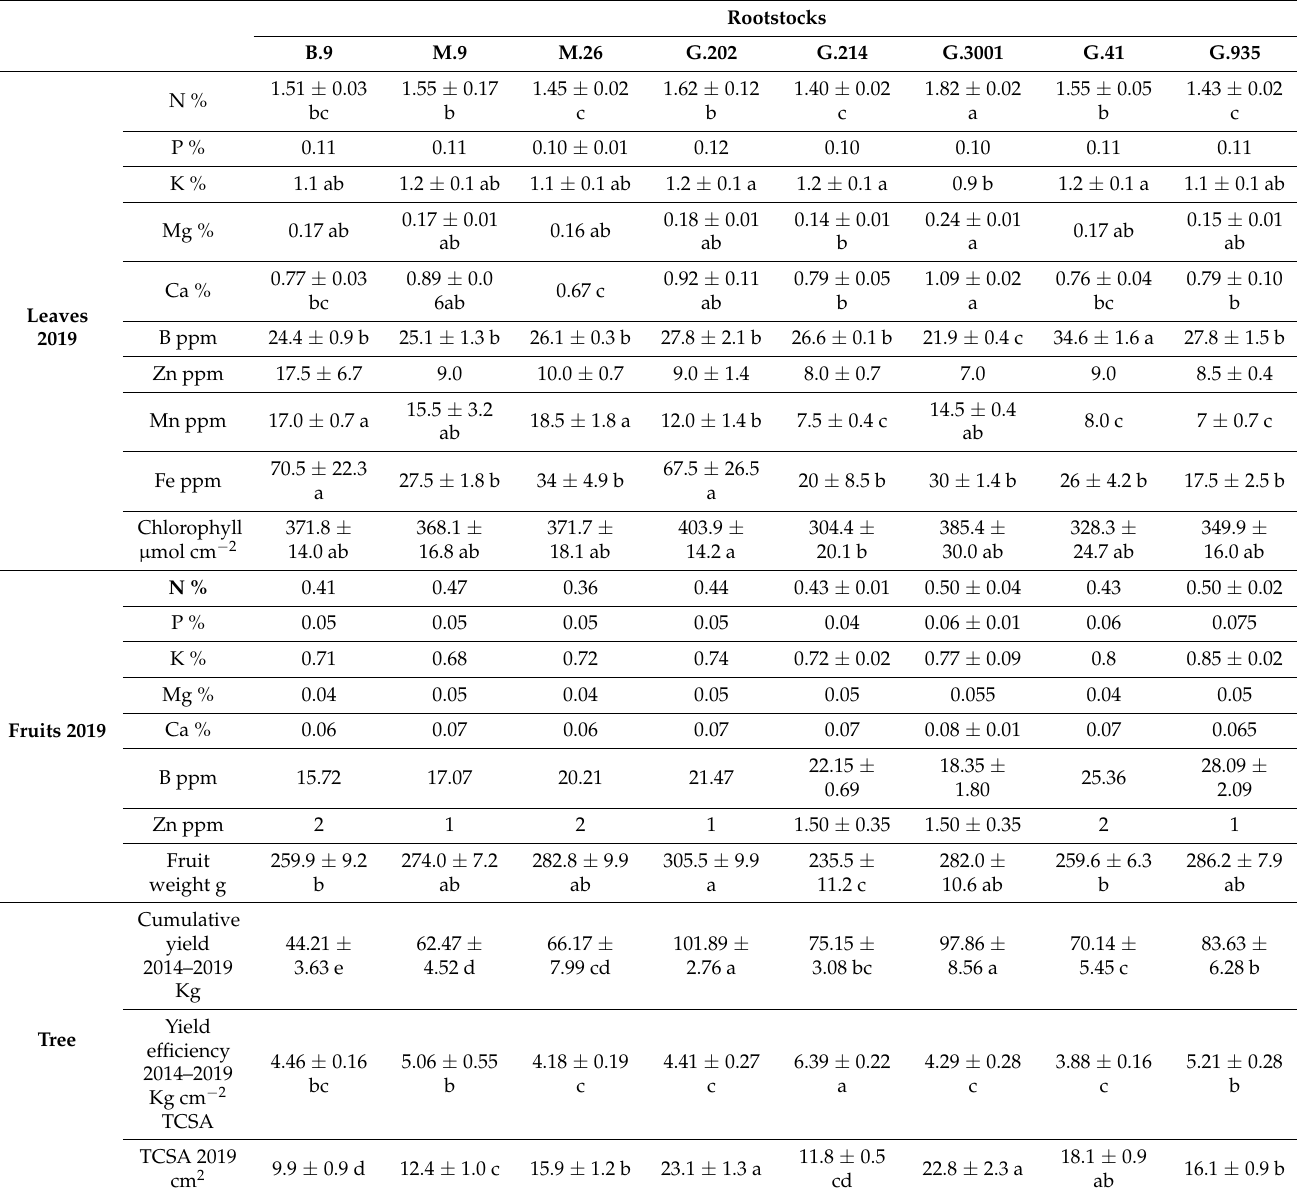
Table 1. Leaf mineral nutrient levels, chlorophyll content, fruit weight, and mineral nutrient levels, trunk increment, and yield efficiency of Honeycrisp scions on eight